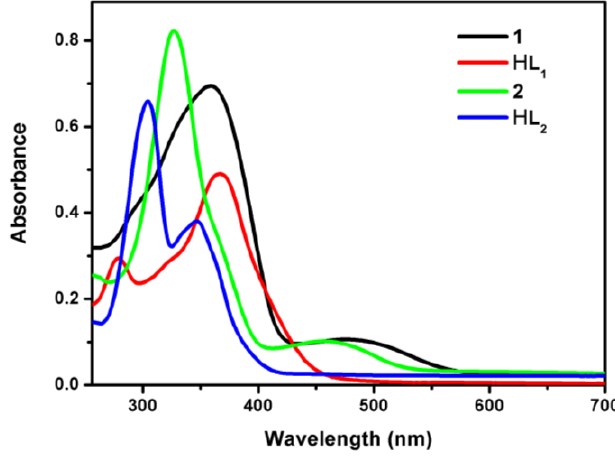
Figure 9. UV-Visible absorption spectra of H L 1 , H L 2 , 1 , and 2 in DMF solution (1.5 mM).